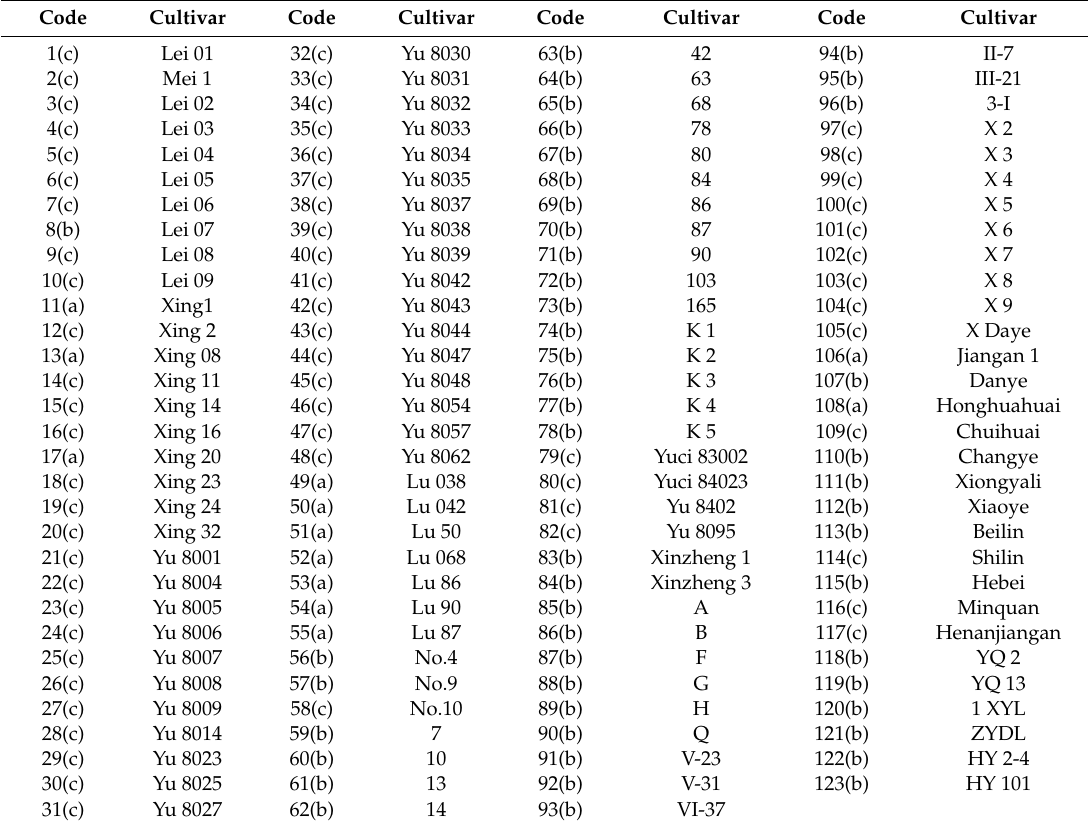
Table 1. The 123 main cultivars of black locust ( Robinia pseudoacacia